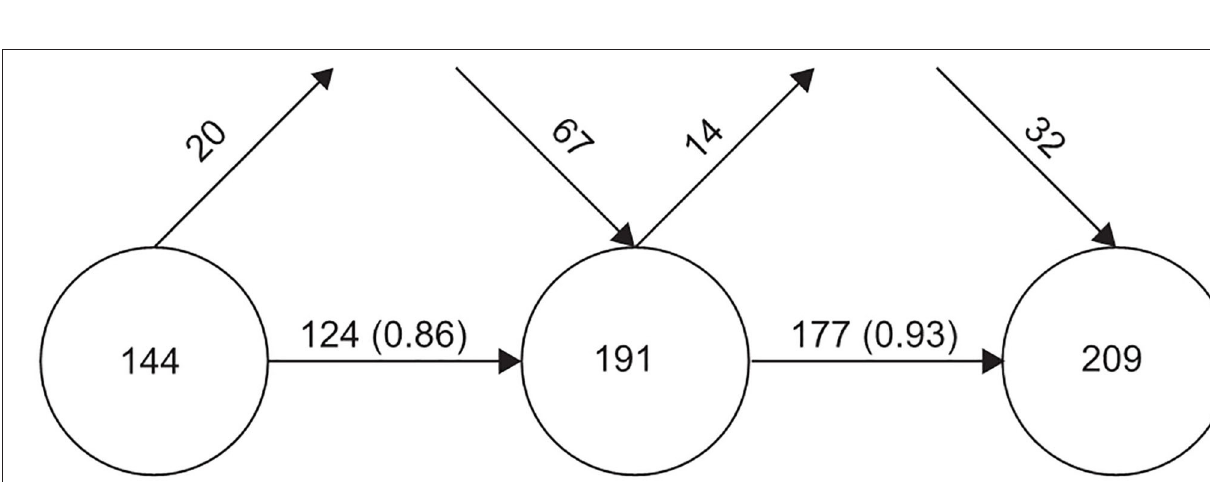
FIGURE 6 | The thematic overlapping map of dietary factors of